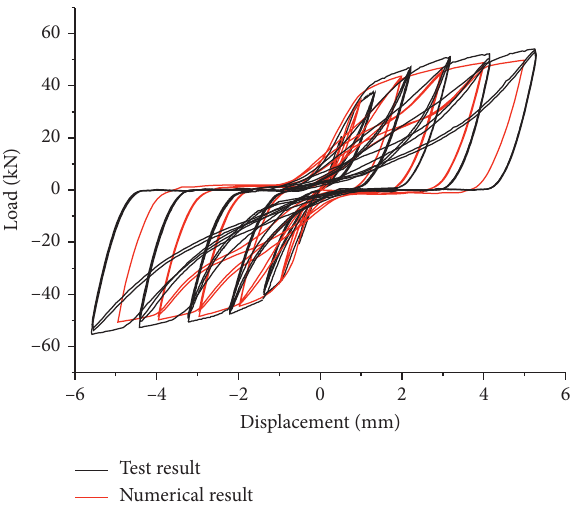
Figure 9: Comparison between experimentally obtained and numerical predicted hysteretic